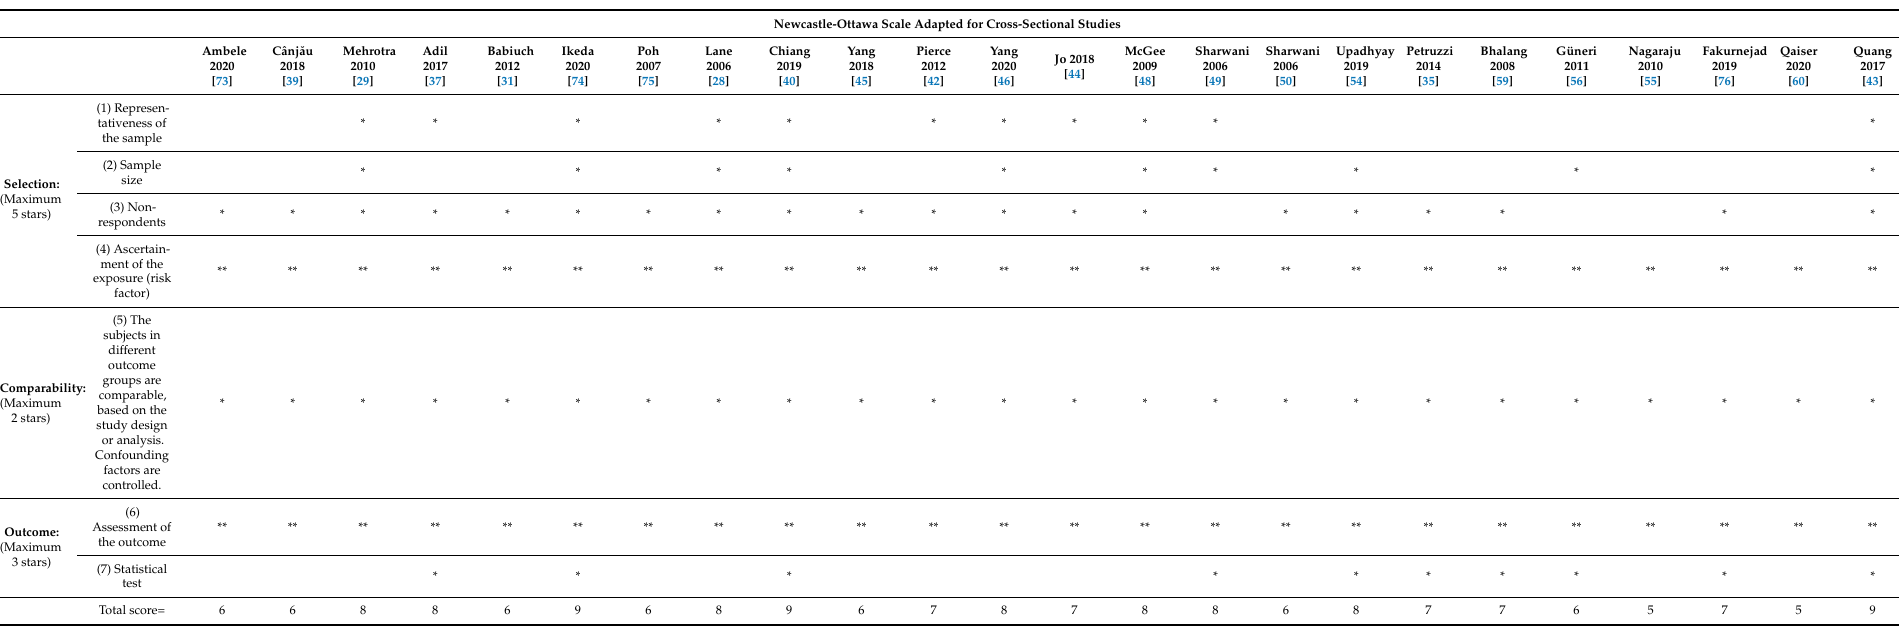
Table 3. Newcastle-Ottawa Scale adapted for cross-sectional